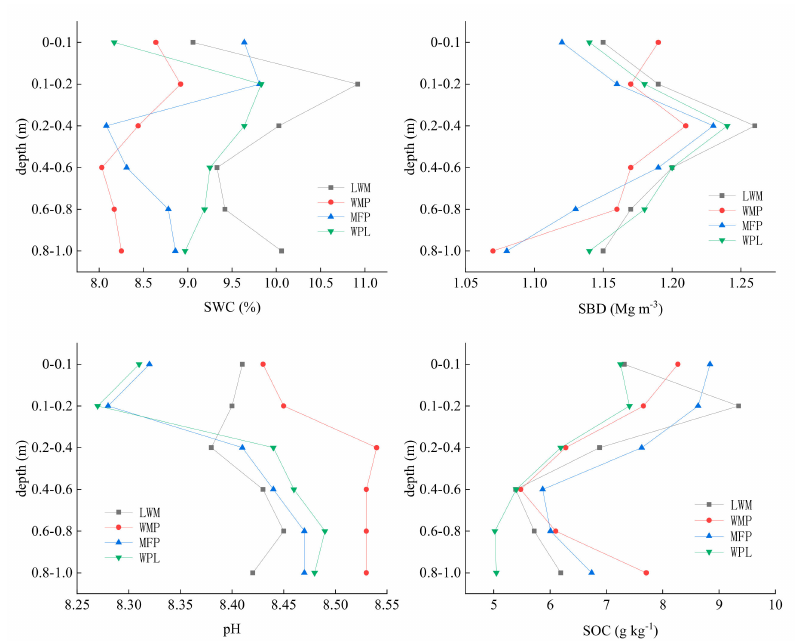
Figure 2. SWC, SOC, SBD, and soil pH at 1 m depth for di ff erent crop rotation patterns. Note: LWM represents lentil–wheat–maize, WMP represents wheat–maize–potato, WFP represents wheat–flax–pea, WPL represents wheat–potato–lentil; SWC represents soil water content, SOC represents soil organic carbon, SBD represents soil bulk